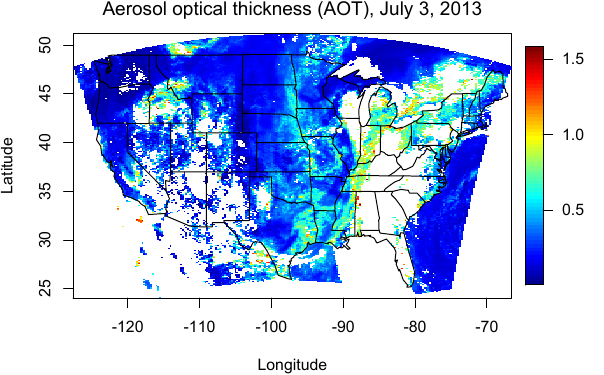
Figure 3. AOT on 3 July 2013.